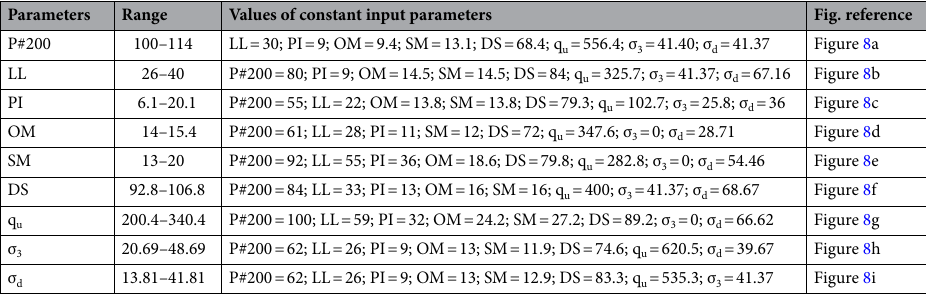
Table 10. Details of simulated